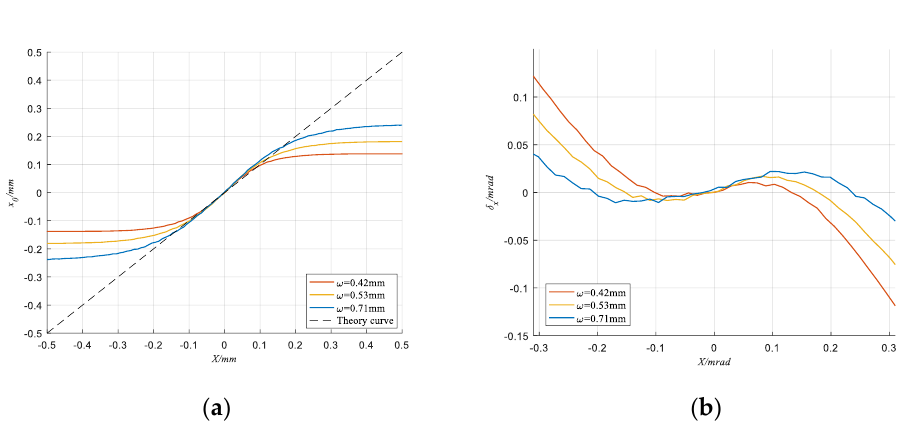
Figure 9. When SNR = − 7.66 dB, detection results of TRC method under different spot radius. ( a ) The Calculated coordinate curve; ( b ) Absolute error.